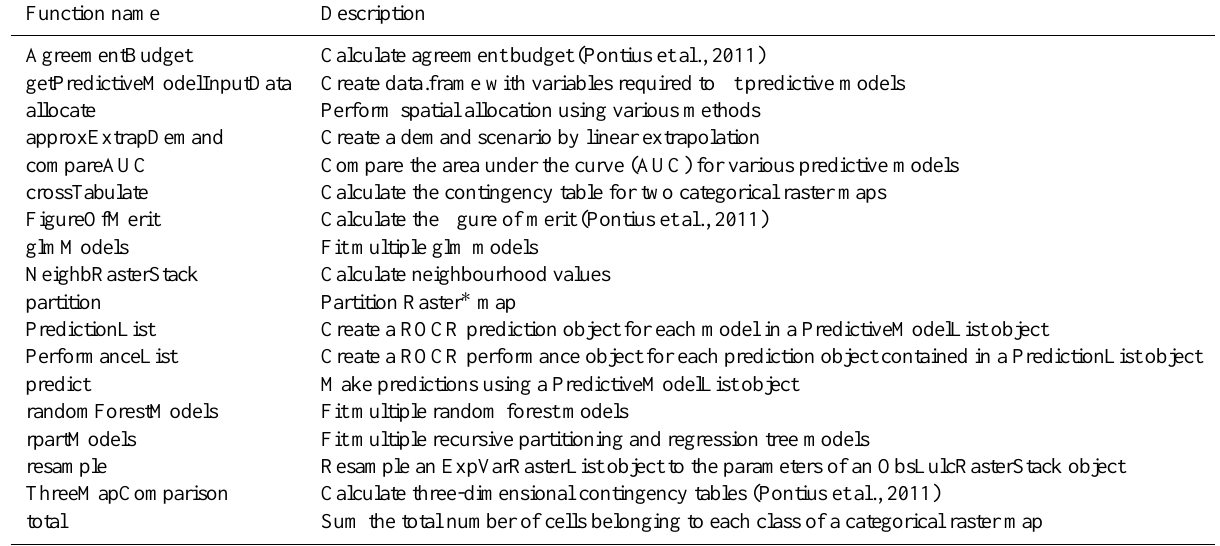
Table 1. Functions included in the lulcc